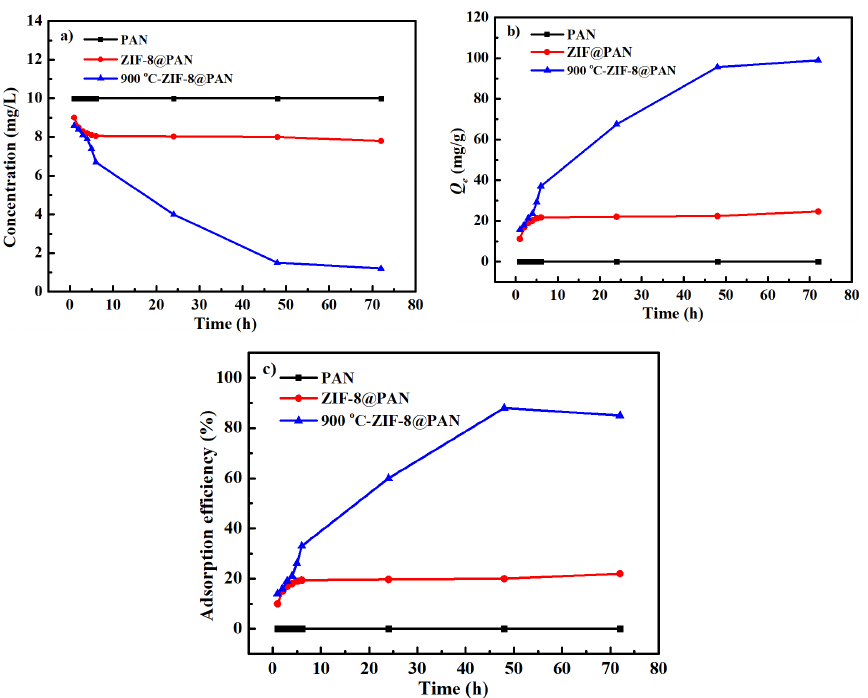
Figure 6. The Cd 2+ adsorption concentration ( a ), adsorption capacity Q e ( b ), and adsorption efficiency ( c ) of original PAN nanofiber membrane, ZIF − 8@PAN nanofiber membrane, and the carbonized ZIF − 8@PAN nanofiber membrane.